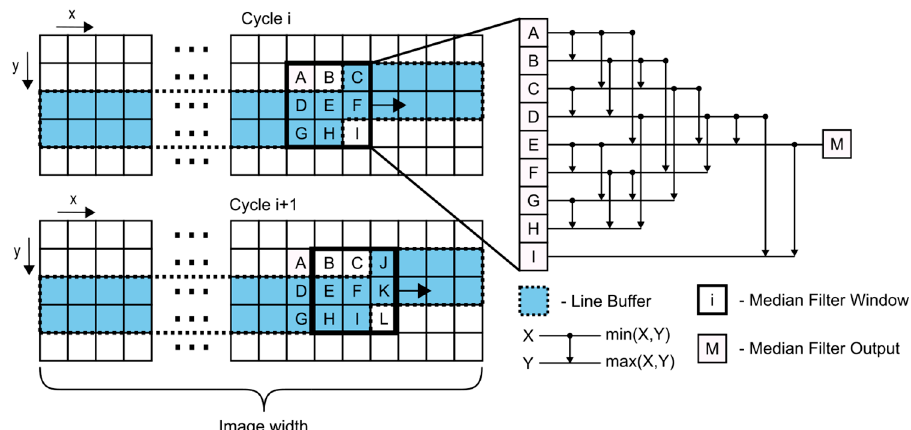
Figure 6. Overview of the median filter design. The left part displays the sliding window concept when filtering. The right part displays the sorting network. A 3 × 3 median window requires 19 compare-and-swap operations. CAS symbols are taken from [13].